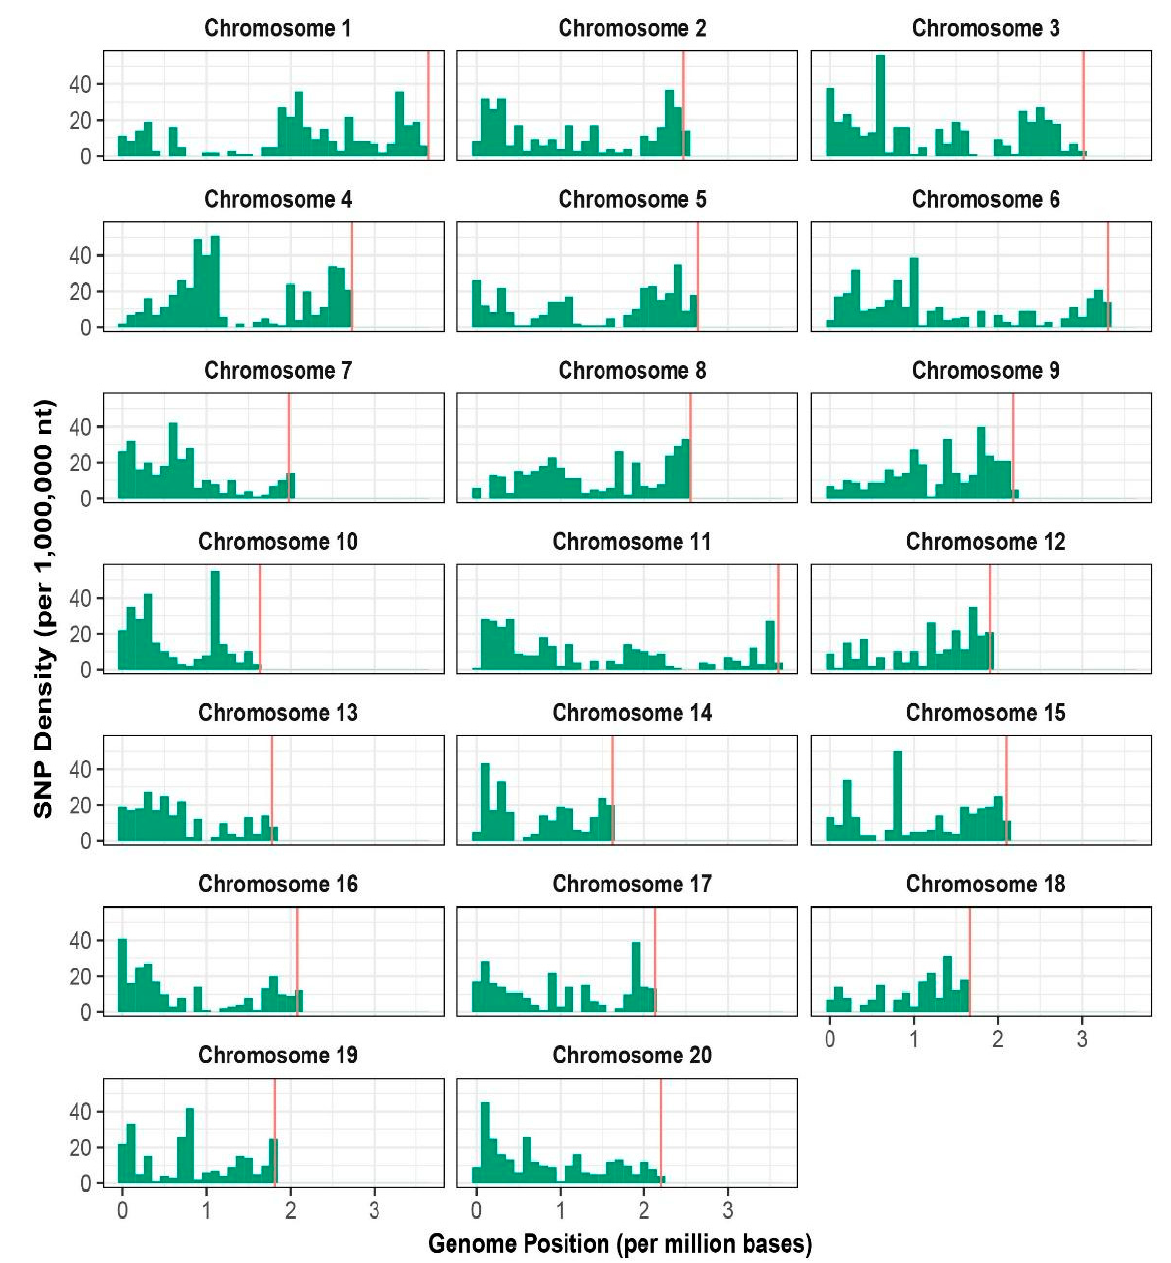
Figure 1. Genome-wide density plot of 5922 SNPs in the tarwi genome.